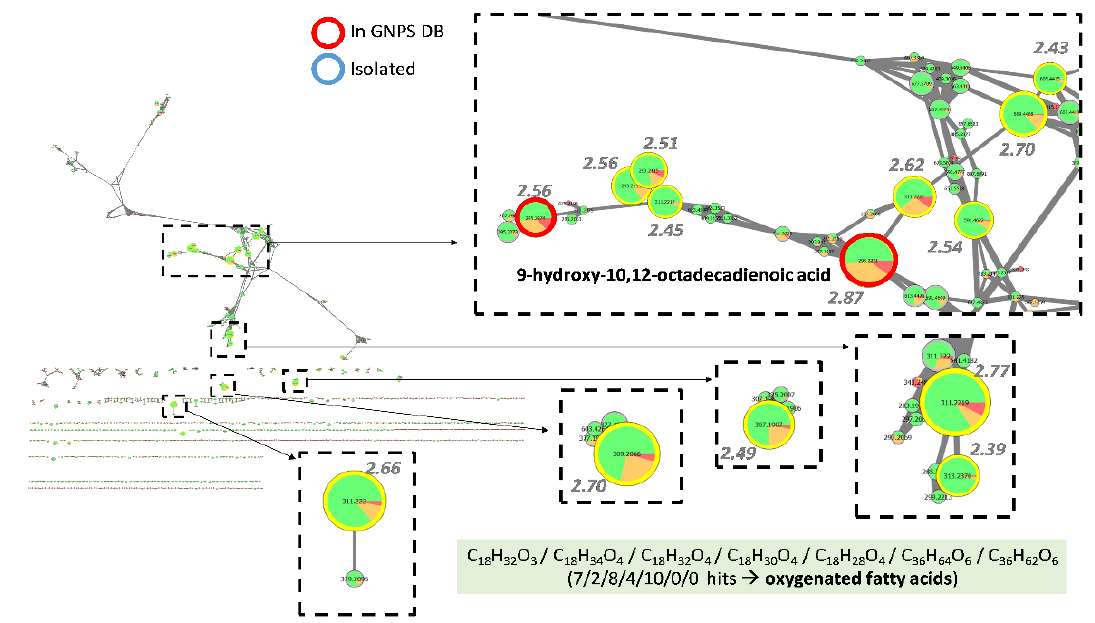
Figure 5. Feature-based molecular network corresponding to Preussia extracts. Nodes are filled with pie charts representing the mean peak areas for each feature in the 3 defined groups of activity (anti-maturation activity at 50 µ g/mL in 48 h): low (red) for 0–40%, medium (orange) for 40–50% and high (green) for 50–100%. Node sizes are related to FiBiCo scores indicated in grey, highlighting compounds mostly linked to the activity